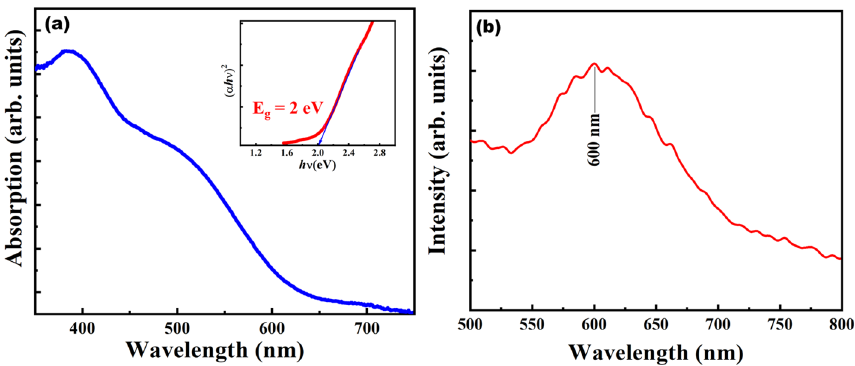
Figure 8. ( a ) Optical absorption spectra (inset Tauc plot to measure bandgap) ( b ) CL spectra of BFO.